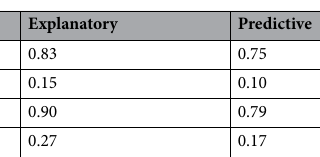
Figure 2. On-effort single-species sightings of ( a ) Australian humpback dolphins ( Sousa sahulensis ) and ( b ) Indo-Pacific bottlenose dolphins ( Tursiops aduncus ), and ( c ) mixed-species sightings of both species, as well as ( d ) overall presence-absence of the species in 540 grids of 500 × 500 m distributed around the North West Cape, Western Australia, from six years of surveys (2013–2015, 2018–2019, and 2021). Species Measure Explanatory